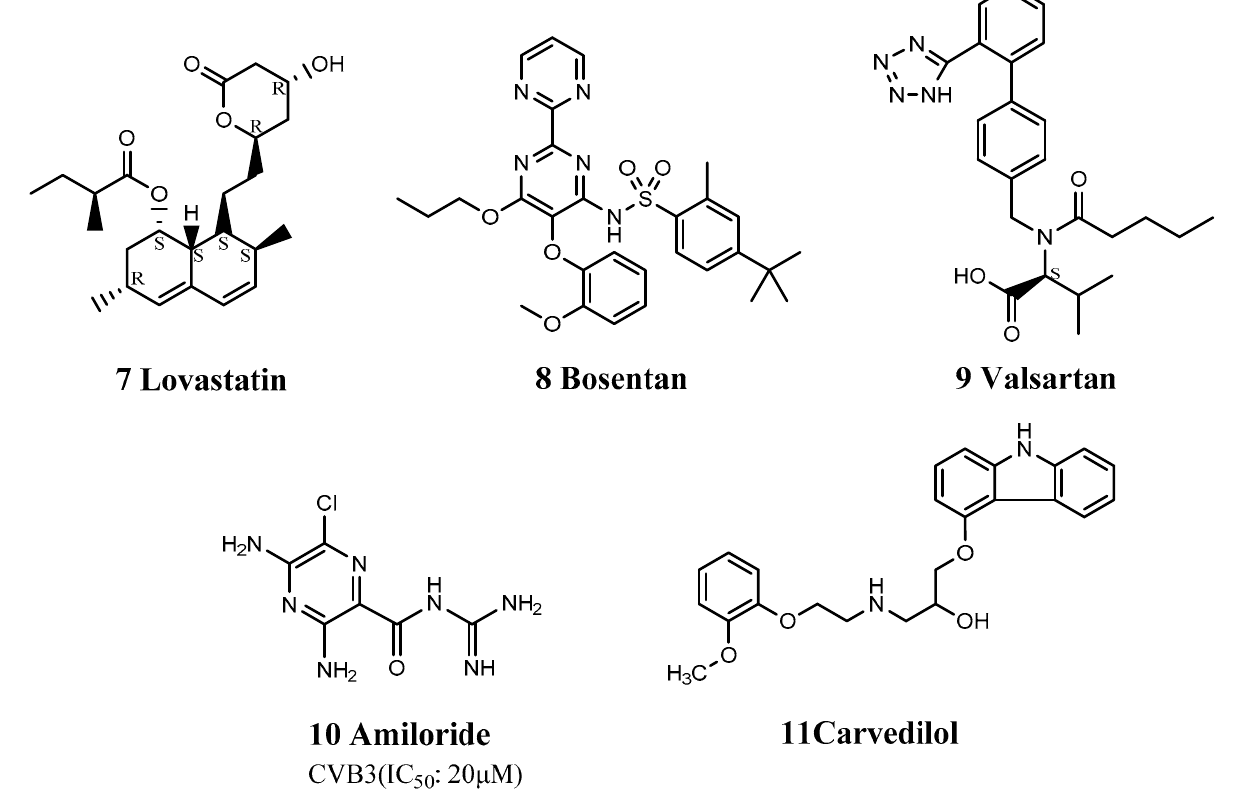
Figure 3. Structures of cardiovascular drugs.